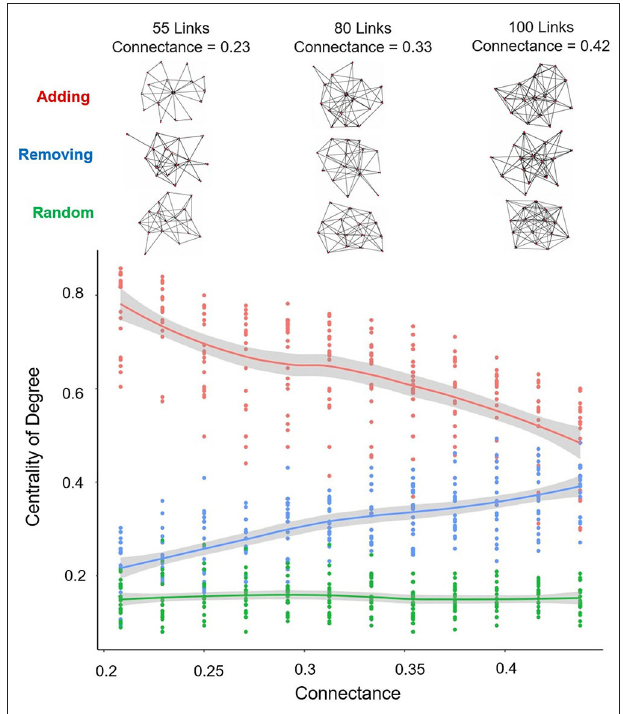
FIGURE 8 | Relationship between the centrality of the final networks (mean and 95% confidence interval shown) and their connectance, along the link up path (red line), the link down path (blue line), and random networks (green line). Upper part: some examples of the networks topologies along the process shown in the graph